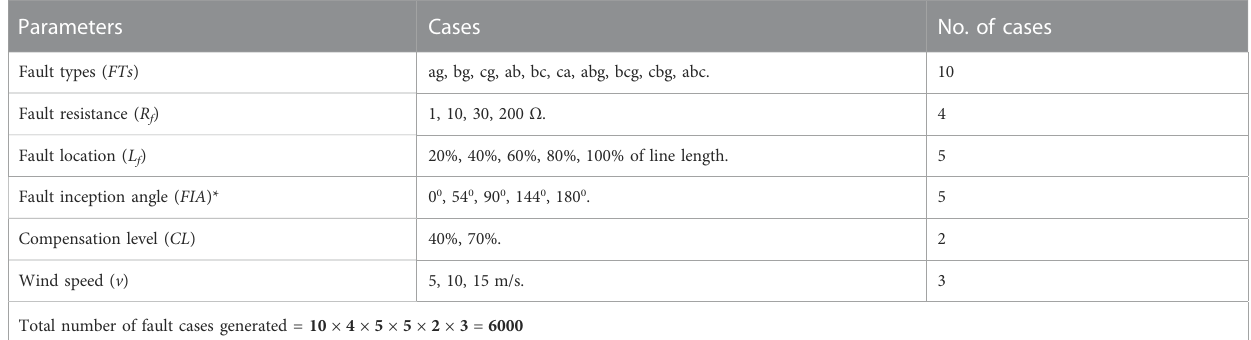
TABLE 1 Parameter variation for the generated 6000 possible fault cases.